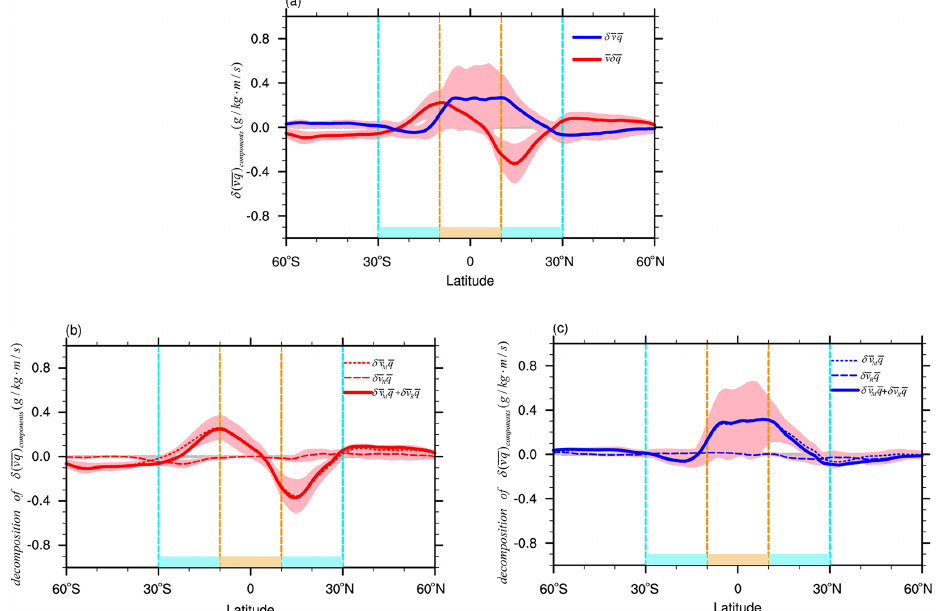
Figure 6. (a) The zonal mean of meridional moisture transport anomalies induced by thermodynamic and dynamic effects for the mid- Pliocene compared with PI simulations. Panels (b) and (c) show the thermodynamic and dynamic terms in panel (a) that are induced by the meridional wind V M and V R decomposed from the 3P-DGAC method, respectively. Here, the tropical region is defined as the region between 10 ◦ S and 10 ◦ N (marked as an orange band), whereas the subtropical region refers to 10–30 ◦ N and 10–30 ◦ S (marked as a cyan band). The shading indicates 1 standard deviation of individual models departing from the MMM. (Units are gkg − 1 ms − 1 .)